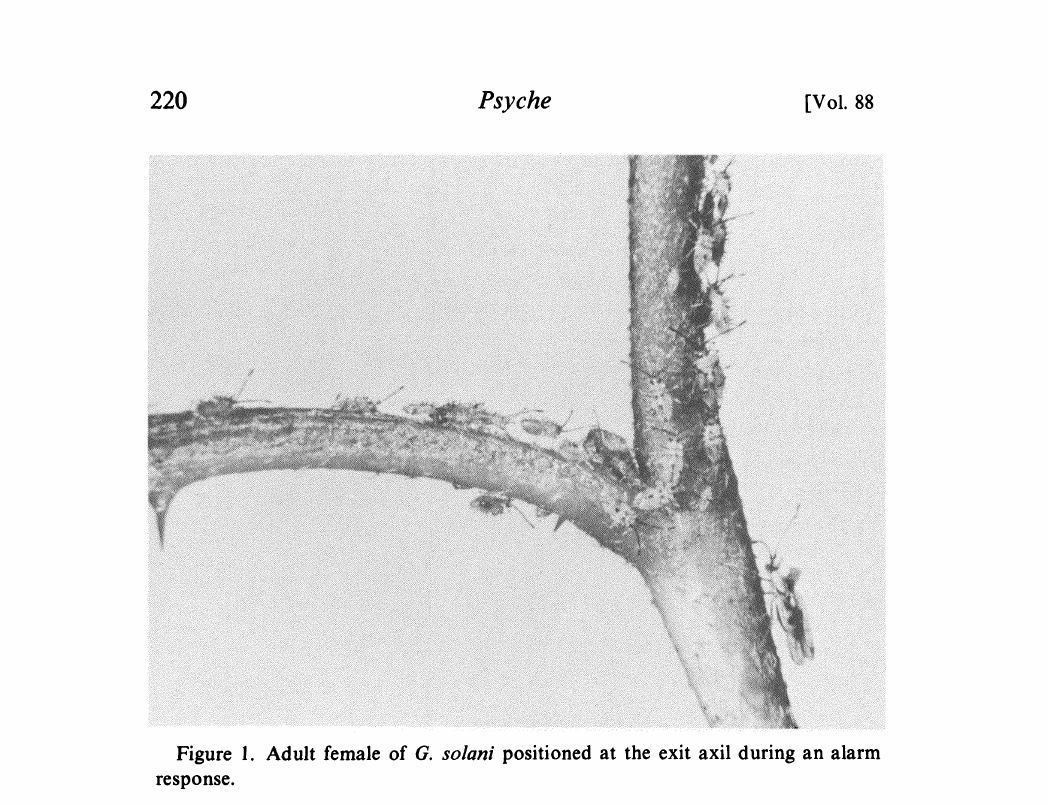
Figure 1. Adult female of G. solani positioned at the exit axil during an alarm